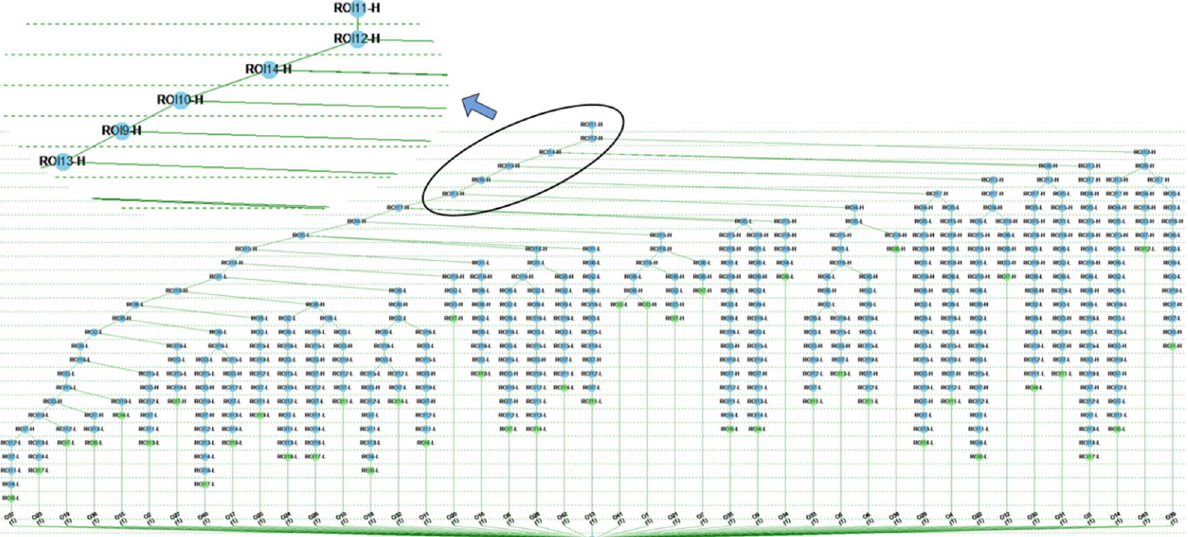
Figure 6. APOS diagram of IRT characteristics of control